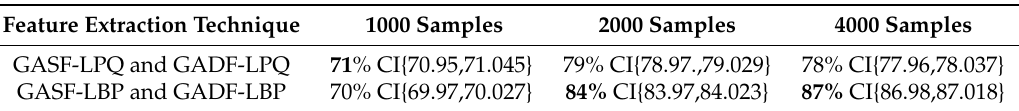
Table 3. Average classification accuracy and 95% CI results with varied window size of segments. Best performance is in bold font.